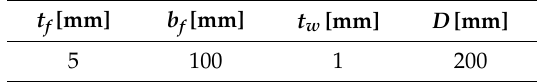
Table 2. Lower bounds for the flange and web dimensions in the harmony search optimisation.